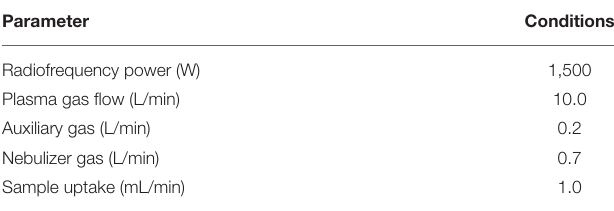
TABLE 3 | Operational conditions of the ICP-OES.